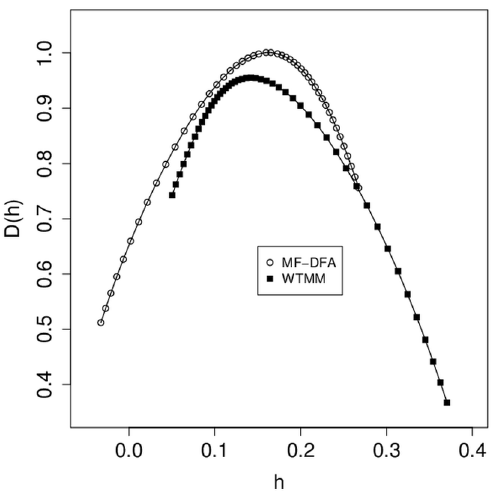
Figure 3. Comparison of waking EEG between MF-DFA and WTMM. For 14 subjects with 8 m of EEG from waking data per subject, MF-DFA and WTMM spectra were calculated for each 8 m EEG series. Average multifractal spectra for each technique shown here were calculated by averaging individual spectra across subjects: mean_h 6 s.d. is 0.12 6 0.03 for MF-DFA, and 0.17 6 0.04 for WTMM.